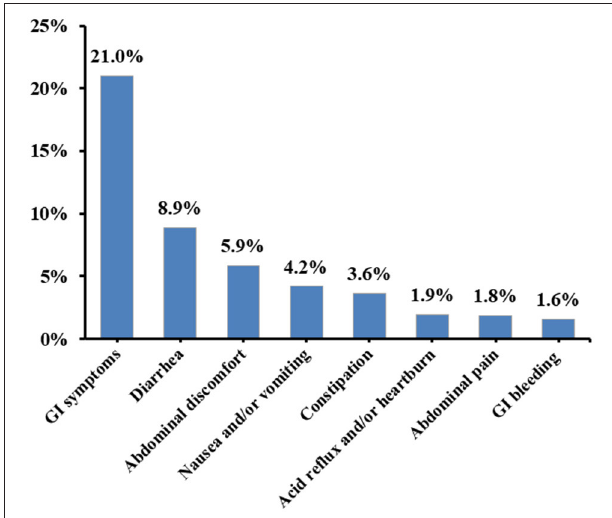
FIGURE 1 | Prevalence of various GI symptoms in COVID-19